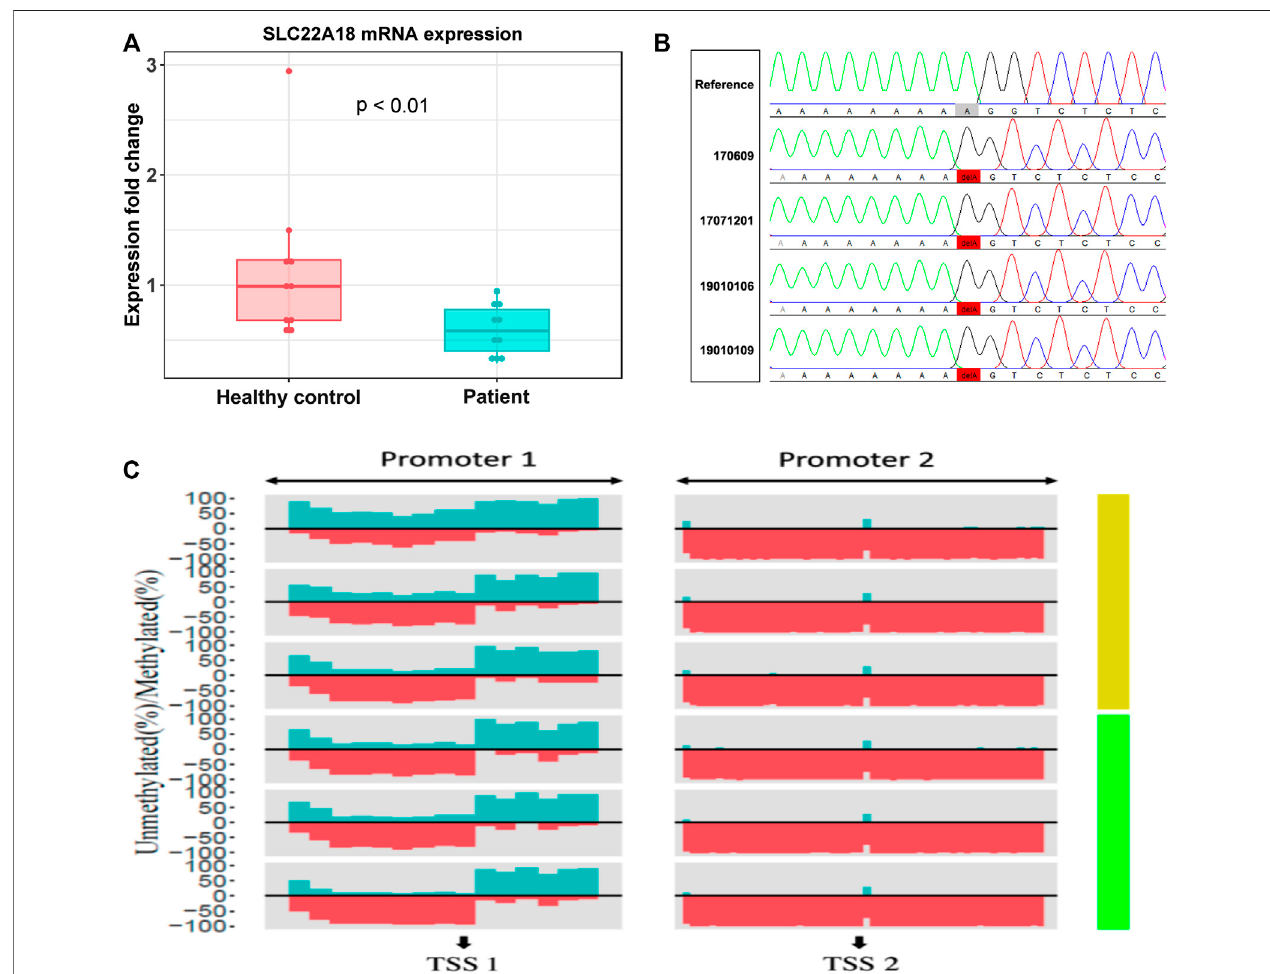
FIGURE 3 | Thefocalpointofapatrilinealimprintedgene SLC22A18 . (A) ComparisonofSLC22A18expressionlevelsbetweenpatientsandhealthycontrols.Thereare10 individuals in each group, and the expression levels were measured by RT-qPCR, and fold changes were calculated with the healthy controls as the reference. The p -value indicatedintheplotwasbasedonatwo-tailedStudent ’ st-testintheRlanguage. (B) TheleftpanelshowstheIDsofpatientswiththisvariant,andthereferencesequenceisonthe top. The solid red box highlights the variant where an “ A ” has been deleted. The visualization of Sanger sequencing results was done by novoSNP. (C) The percentage of methylated and methylated CpG sites was represented by dark green and red, respectively. Patients and healthy controls were represented by light green and yellow bars, respectively, on the right side. “ TSS1 ” is located at position 2, 899, 721, “ + ” strand, chromosome 11; “ TSS2 ” is located at position 2, 902, 282, “ + ” strand, chromosome 11.